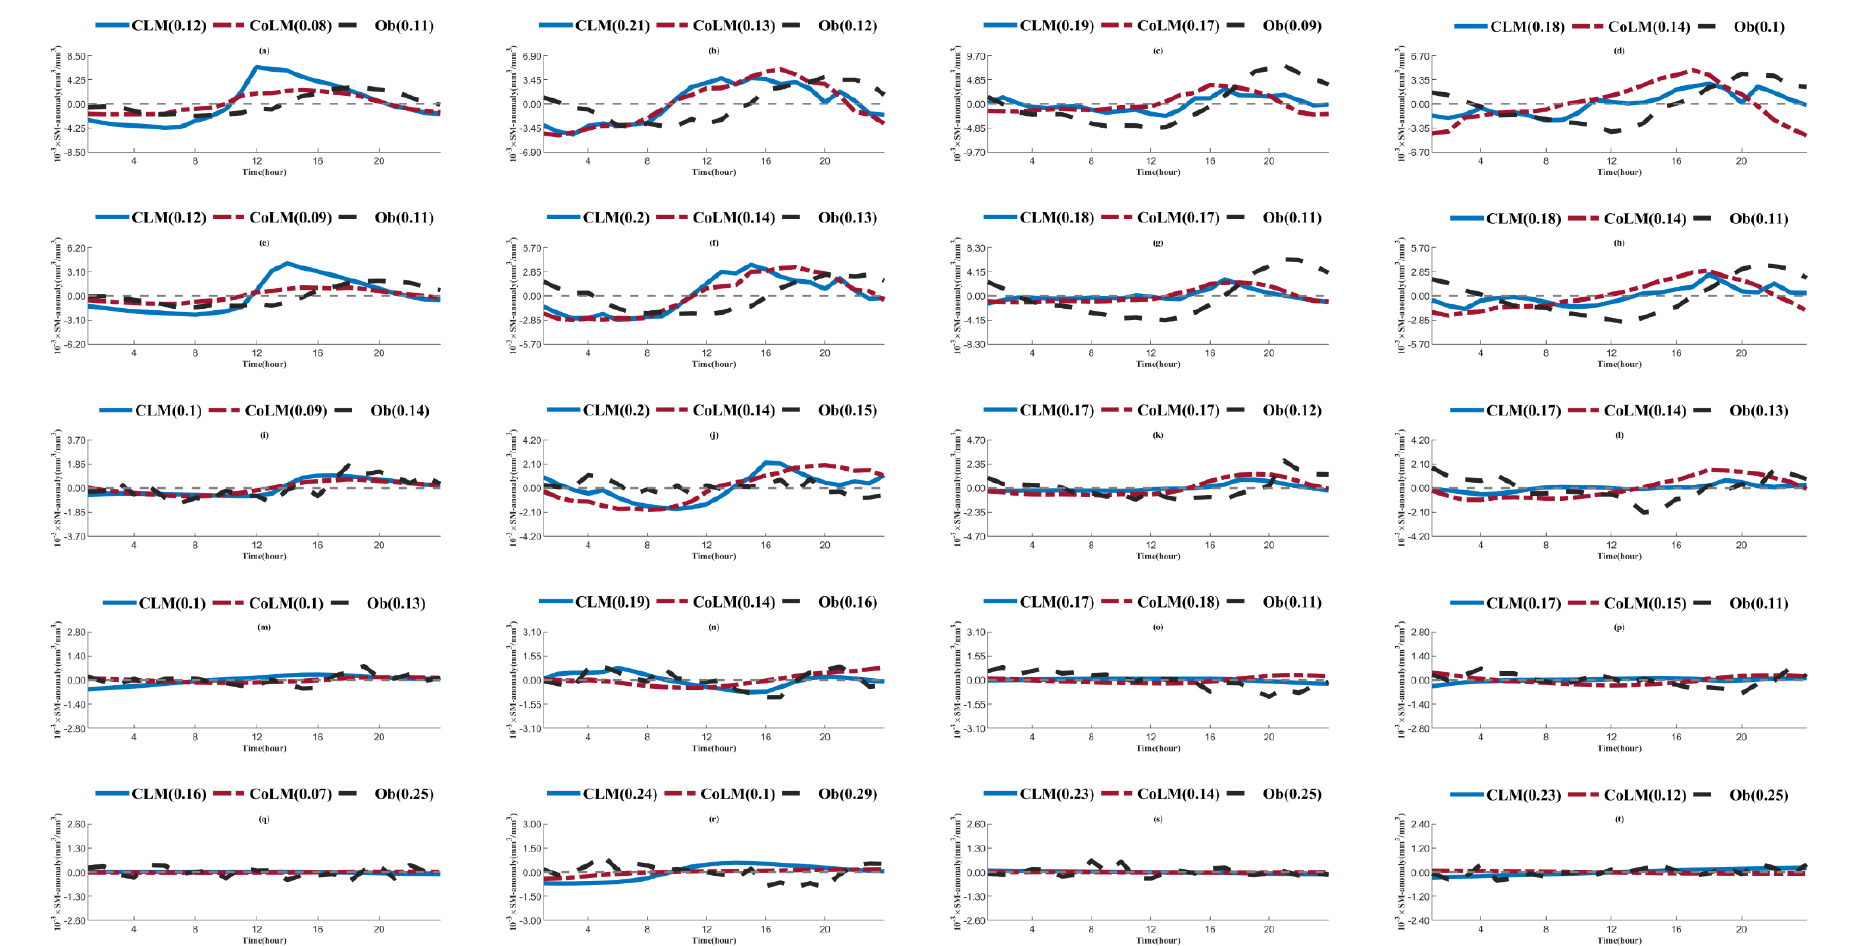
Figure 7. Diurnal variations in soil moisture anomalies for the four seasons at the Little River site, with CLM5 in blue, CoLM2014 in red, and observations in black. The seasonal mean values of soil moisture are in brackets. Soil moisture anomalies in ( a , e , i , m , q ) winter in layers 1 to 5, respectively; ( b , f , j , n , r ) spring in layers 1 to 5, respectively; ( c , g , k , o , s ) summer in layers 1 to 5, respectively; and ( d , h , l , p , t ) autumn in layers 1 to 5, respectively.